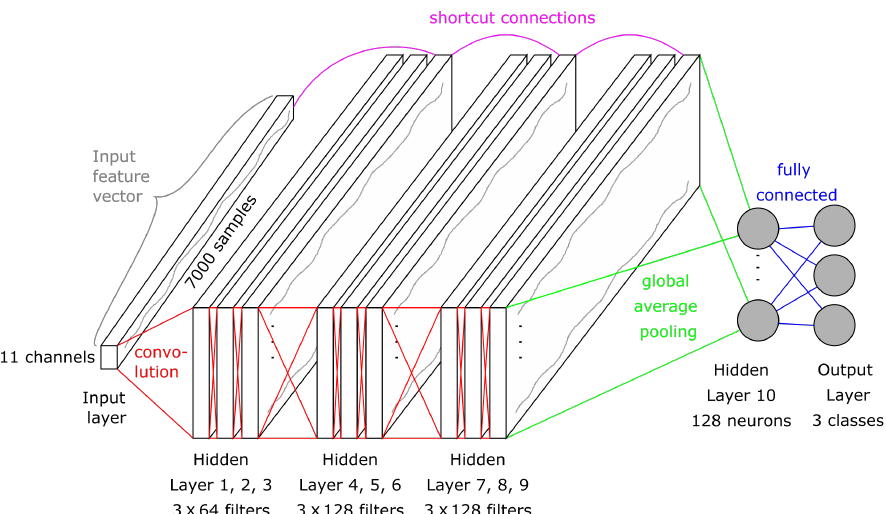
Figure 8. Visualization of the ResNet architecture for the three shot types classification. The first 9 hidden layers are divided into 3 × 3 similar blocks. Each block has a shortcut connection to the previous one.